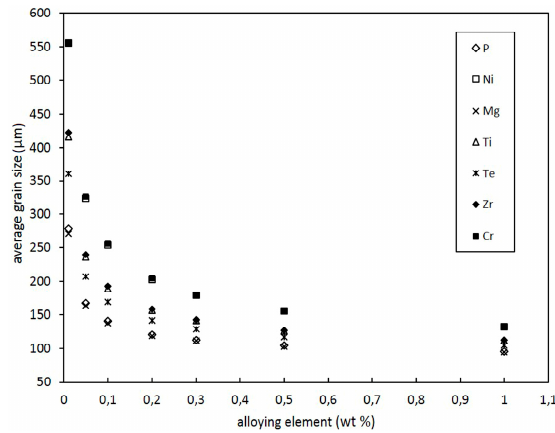
Figure 1. Predicted grain size vs. concentration for the alloying elements under investigation. S and Bi are not included in the figure.